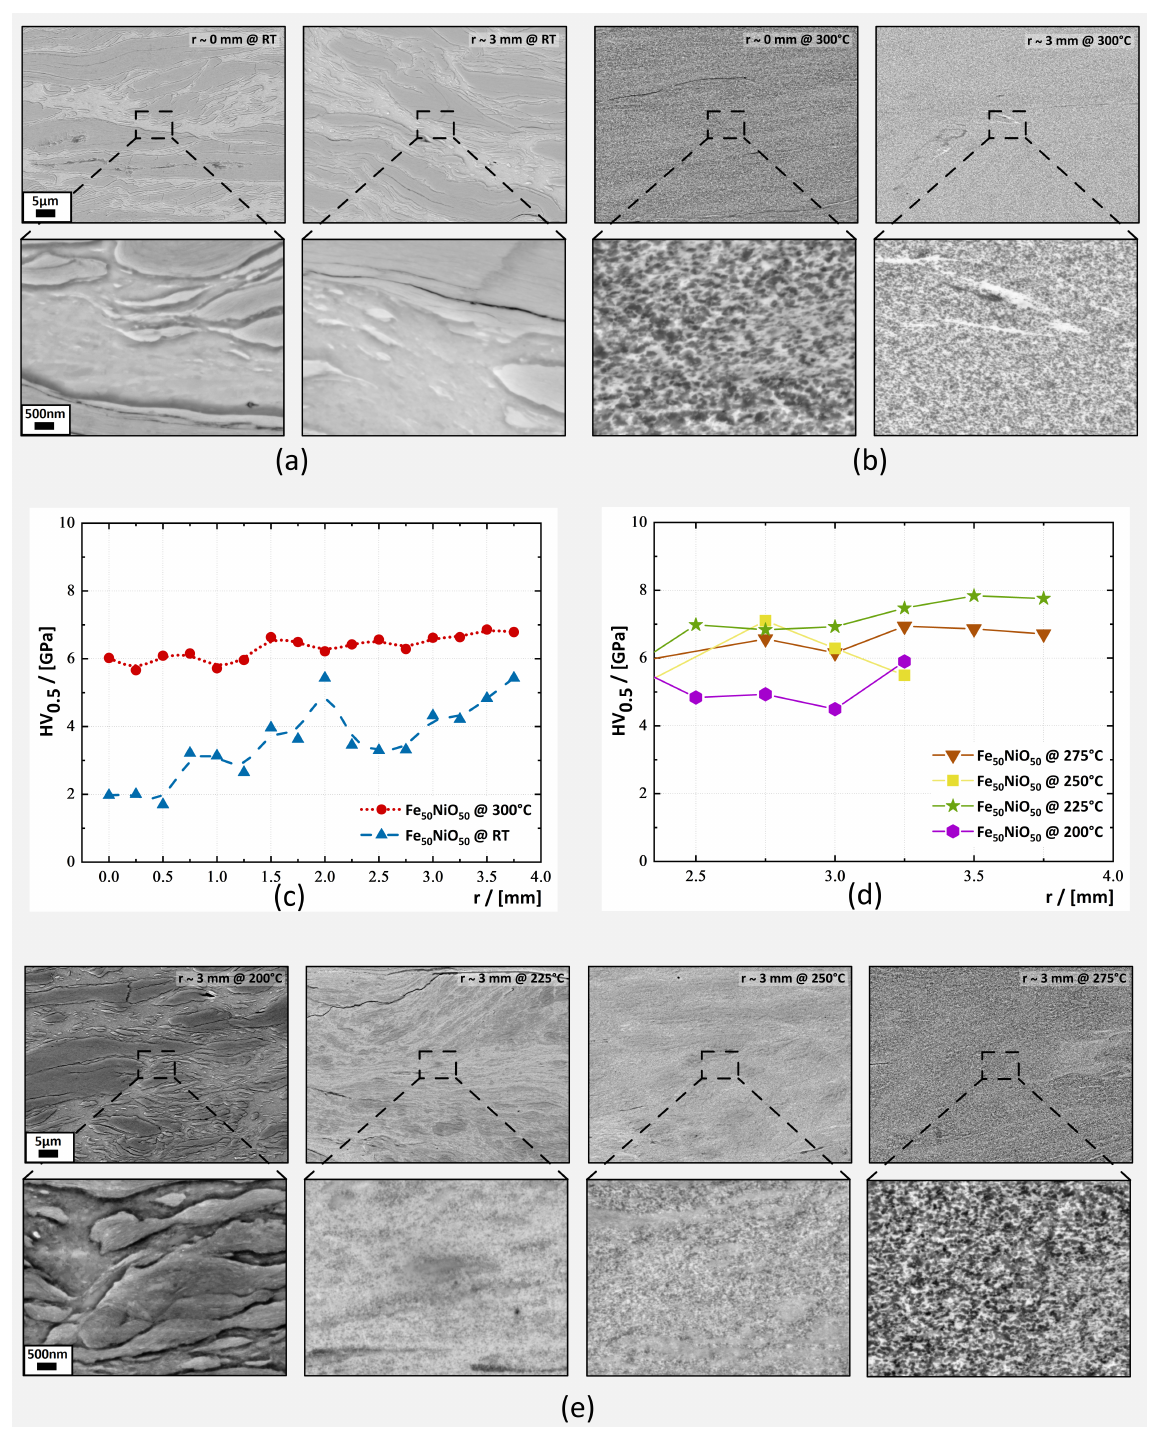
Figure 1. SEM micrographs in BSE mode depict samples deformed at RT ( a ) and 300 °C ( b ) at r = 0 mm and r = 3 mm. EDX spectroscopy identified the dark phase as NiO for ( a ) or Fe 3 O 4 for ( b ). ( c ) Vickers microhardness of Fe 50 NiO 50 samples along the radial direction. The sample processed at 300 °C had a higher saturation microhardness compared to the sample deformed at RT. ( d ) Vickers microhardness values form r = 2.5 mm to r = 3.75 mm. Higher deformation temperatures led to a homogeneous microstructure and therefore higher hardness values. ( e ) SEM micrographs in BSE mode gained of Fe 50 NiO 50 samples at the outer radii ( r ∼ 3 mm). An onset of homogenisation of microstructure could be seen at 225 °C and gradually improved towards 275 °C. The micron bar applies to all micrographs in the same